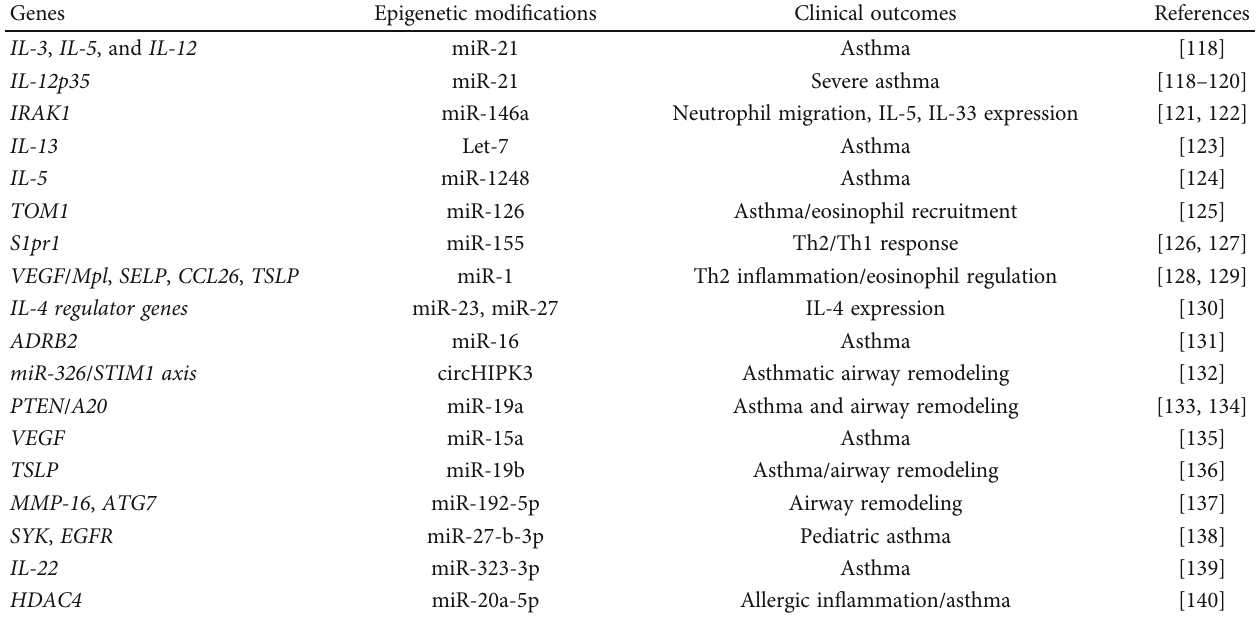
Table 3: miRNAs, epigenetic modi fi cations, and clinical